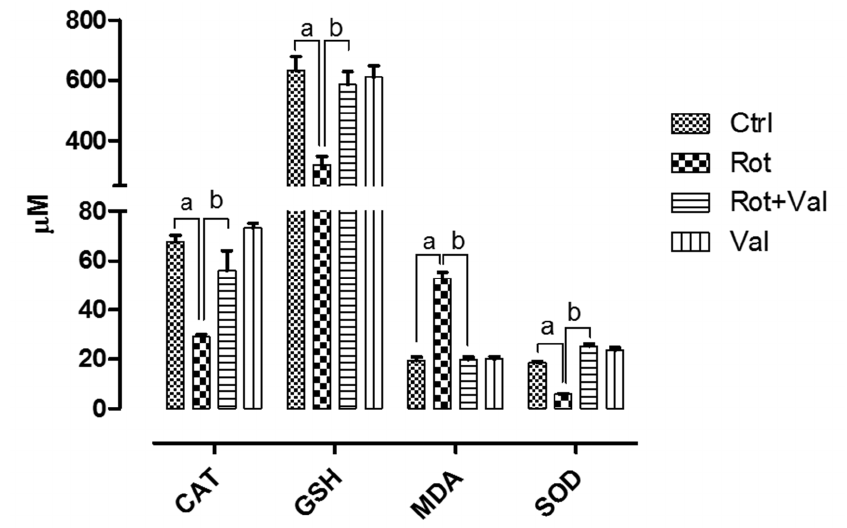
Figure 1. Influence of Valeric acid on rotenone induced oxidative stress and antioxidative indices rats. Rotenone administration caused a significant increase ( p < 0.05) in lipid peroxidation which is represented by increase in malonaldehyde levels with marked decrease in vital anti-oxidants levels in the midbrain. Treatment with 40 mg / kg Valeric acid prevented lipid peroxidation with a significant decrease in MDA levels and ameliorated brains vital antioxidant (CAT, GSH and SOD) levels. There is no significant di ff erence in both MDA and antioxidant levels in control and Val alone treated groups. Data are expressed as mean ± SEM. a p < 0.05 compared to control, b p < 0.05 compared to rotenone treated